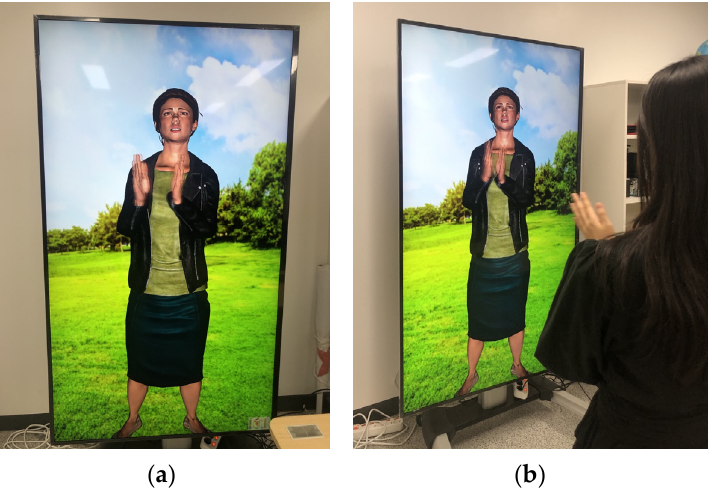
Figure 6. Interaction results between a user and a virtual human: ( a ) The virtual human represented in a large 2D TV. ( b ) According to gesture recognition, the virtual human can express the specific